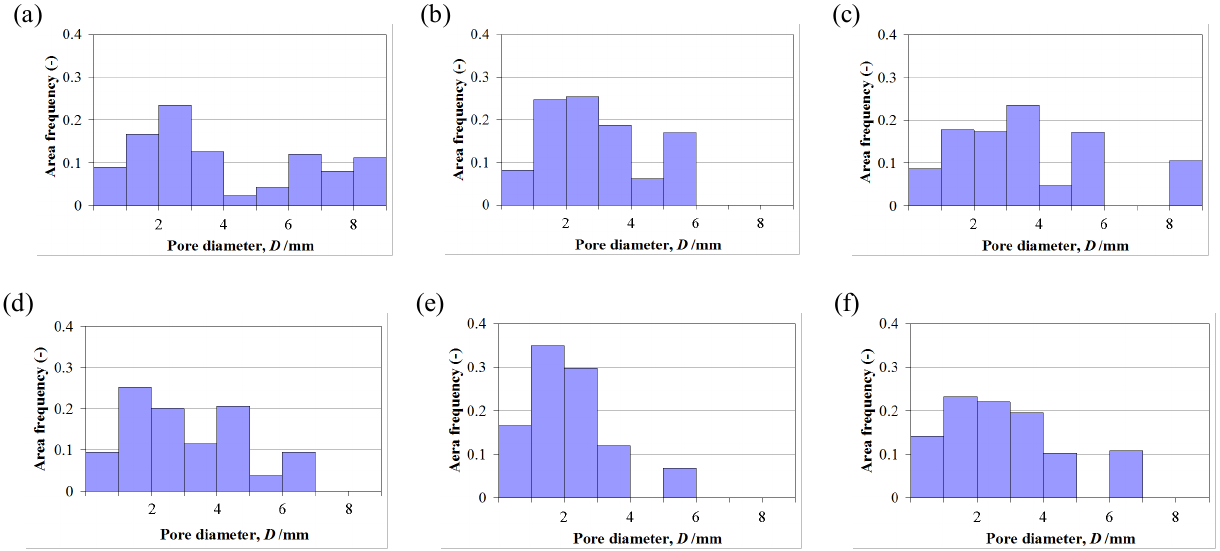
Figure 4. Histograms of pore diameter of samples with various powder sizes. ( a – c ) TiB 2 powder denomination: coarse; ( d – f ) TiB powder denomination: fine; ( a , d ) Ni powder 2 denomination: fine, and Ti powder denomination: fine; ( b , e ) Ni powder denomination: intermediate, and Ti powder denomination: fine; ( c , f ) Ni powder denomination: fine, and Ti powder denomination: